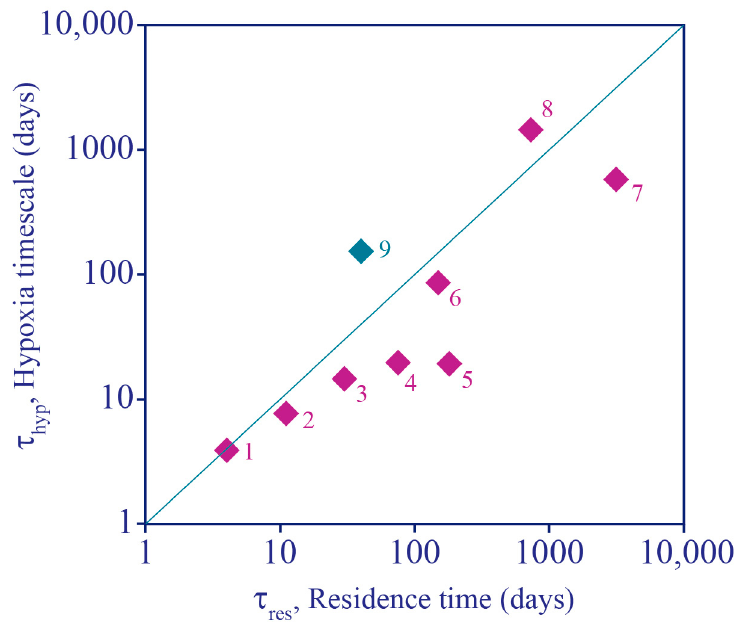
Figure 18. Hypoxia timescale versus residence time for several hypoxic estuarine and shelf systems, as estimated by Fennel and Testa [132]. Systems falling below the diagonal 1:1 line are consistent with the authors’ hypothesis that γ , the ratio of the hypoxia timescale to the residence time, is less than unity for hypoxia to occur. Systems analyzed: (1) Pearl River Estuary (China); (2) East China Sea; (3) Northern Gulf of Mexico; (4) Long Island Sound (USA); (5) Chesapeake Bay (USA); (6) Northwestern Black Sea; (7) Baltic Sea; (8) Gulf of St. Lawrence (Canada); (9) Namibian Shelf. (Redrawn from Fennel and Testa [132] with the permission of K.